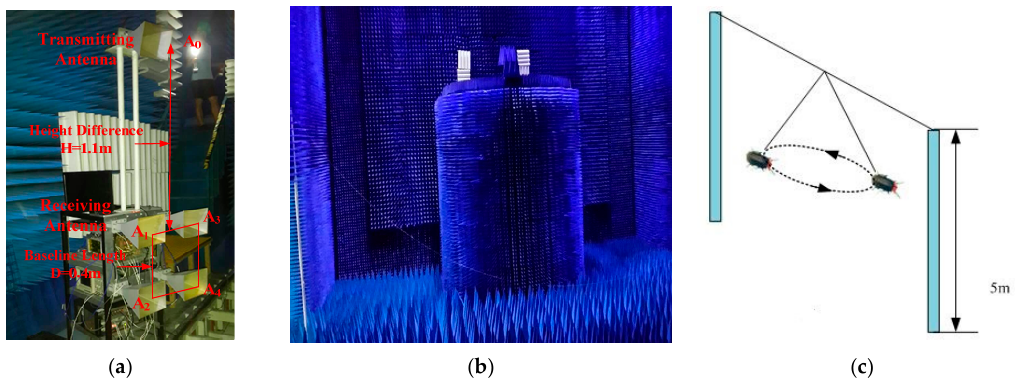
Figure 7. Experimental scene: ( a ) Photo of the S-band radar system; ( b ) photo of the experimental scene in the anechoic chamber; and ( c ) diagram of insect flying.